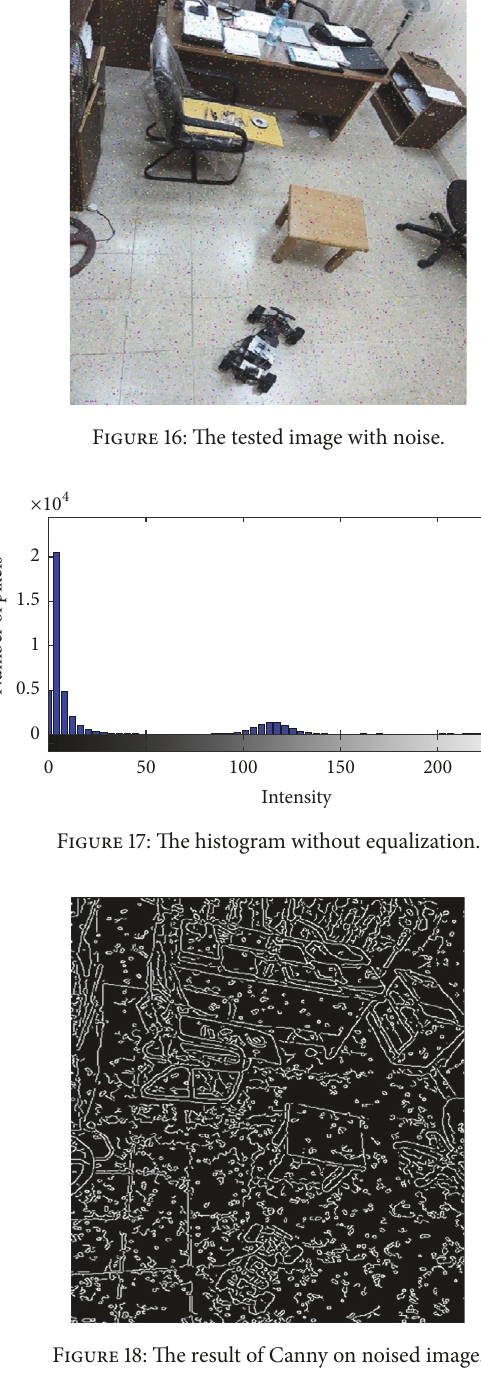
Figure 18: The result of Canny on noised image.